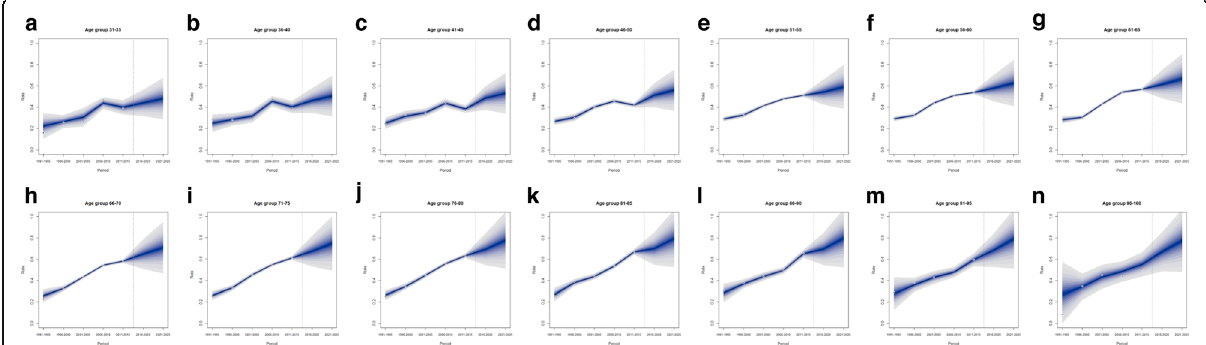
Fig. 5 Pain rates and 10-years pain rate projection per age group in females . a : pain rate projection, females, age 31 – 35. b : pain rate projection, females, age 36 – 40. c : pain rate projection, females, age 41 – 45. d : pain rate projection, females, age 46 – 50. e : pain rate projection, females, age 51 – 55. f : pain rate projection, females, age 56 – 60. g : pain rate projection, females, age 61 – 65. h : pain rate projection, females, age 66 – 70. i : pain rate projection, females, age 71 – 75. j : pain rate projection, females, age 76 – 80. k : pain rate projection, females, age 81 – 85. l : pain rate projection, females, age 86 – 90. m : pain rate projection, females, age 91 – 95. n : pain rate projection, females, age 96 – 100. Note. The predictive mean is shown as solid line. The different shadings indicate pointwise credible intervals. The central interval represents 10% CI, and the largest interval 95% CI. Observed rates are shown as a filled circle. The vertical dashed line indicates where prediction